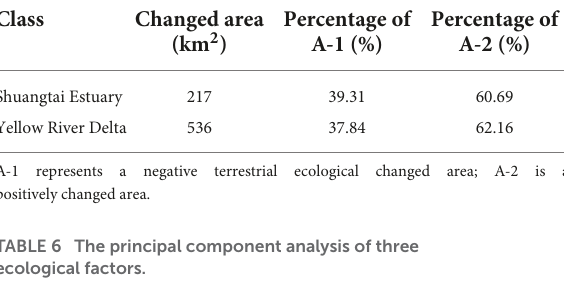
TABLE 5 The percentage of different ecological changed areas.